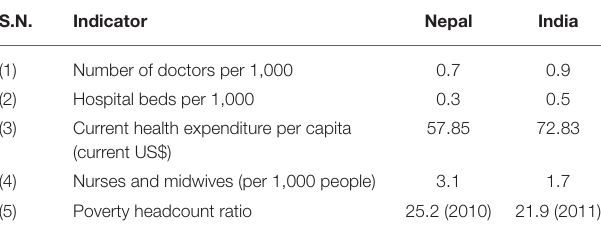
TABLE 1 | Health care/facilities indicator [source: World Bank (38, 39)].